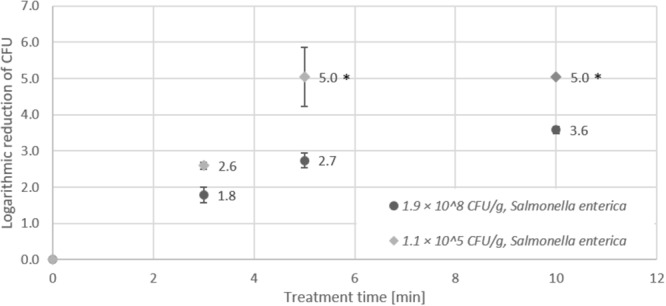
Effect of CAPP treatment of Salmonella enterica on lentil seeds. Inoculation was performed either as high initial inoculation (1.9 × 108 CFU/g) or low initial inoculation (1.1 × 105 CFU/g) prior to treatment of seeds for 3, 5 or 10 min in the DCSBD. Logarithmic reductions were represented as log10 CFU/g ± standard deviation. The limit of detection was 10 CFU/g for low initial inoculation and 100 CFU/g for high initial inoculation. Logarithmic reduction below the limit of detection is indicated by an asterisk.